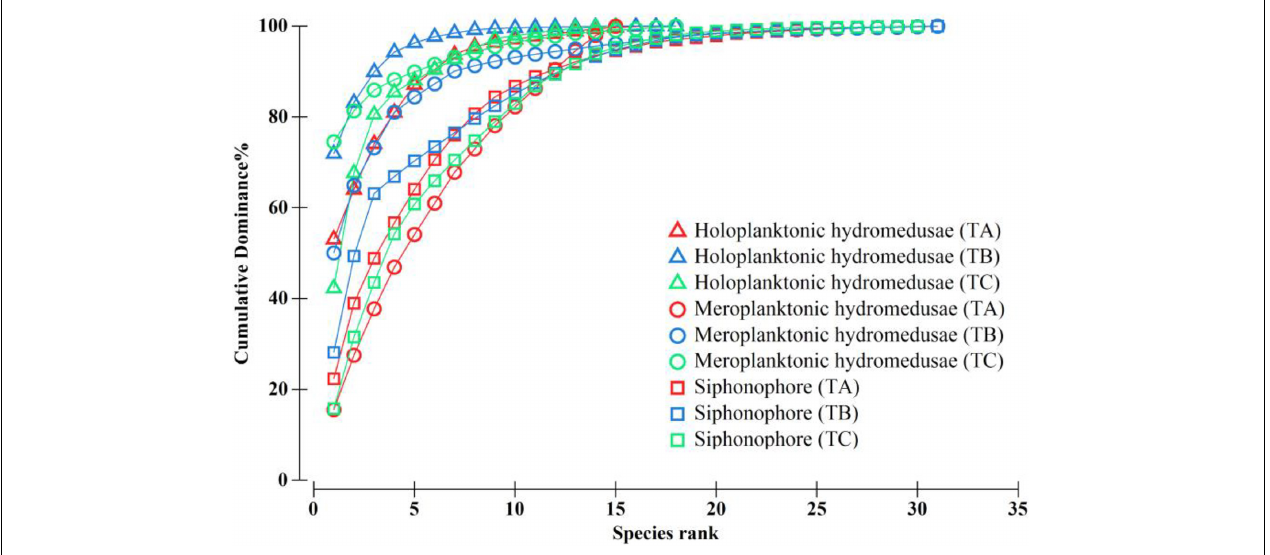
FIGURE 4 | K-dominance curves of different groups of medusae in the wind-driven jet (WJR) and the non-wind-driven jet (NWJR). TA–TC represented transect A, B, and C, respectively.